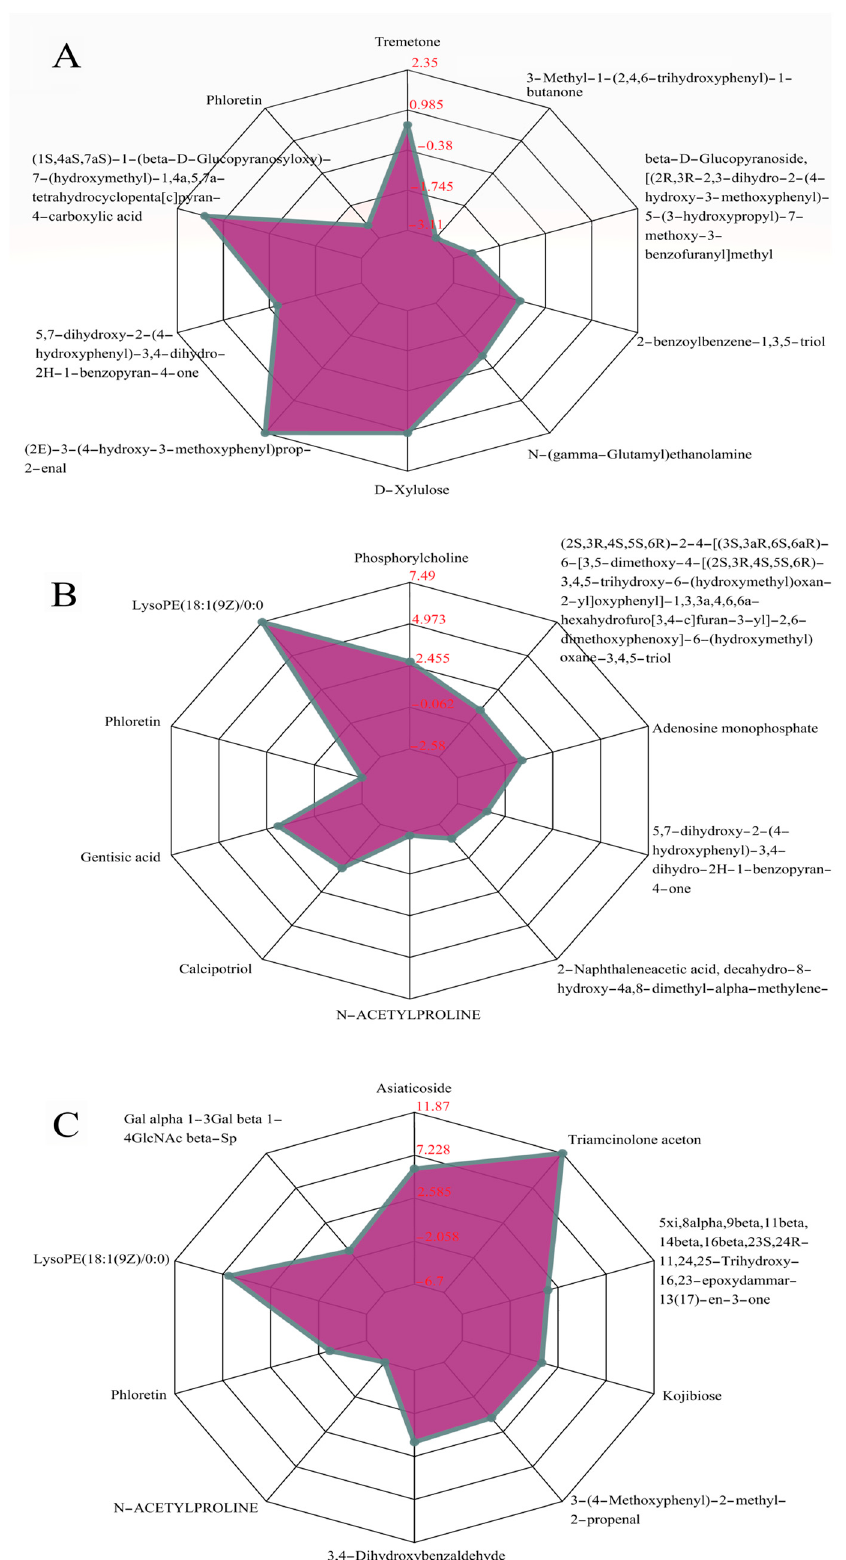
Figure 4. Radar plots of differential metabolites from seeds of C. vietnamensis during different maturation stages. Red fonts in the figures represented the corresponding ratios which were calculated for the quantitative values of the metabolites, and the logarithmic transformation was taken as the base 2. ( A ) S1 vs. S2; ( B ) S1 vs. S3; ( C ) S1 vs. S4.